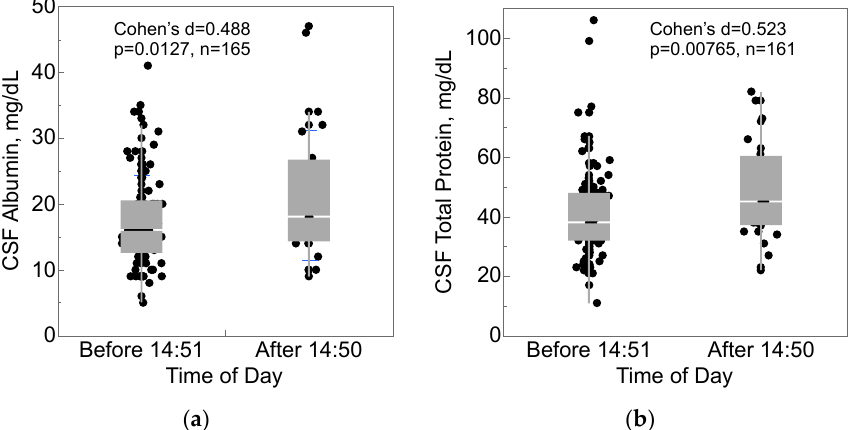
Figure 2. CSF collection time after 2:50 pm was associated with higher ( a ) CSF albumin and ( b ) CSF total protein. Box-and-whisker plots show medians (middle horizontal line), interquartile ranges (box), ranges (whiskers), and Cohen’s d, effect size.